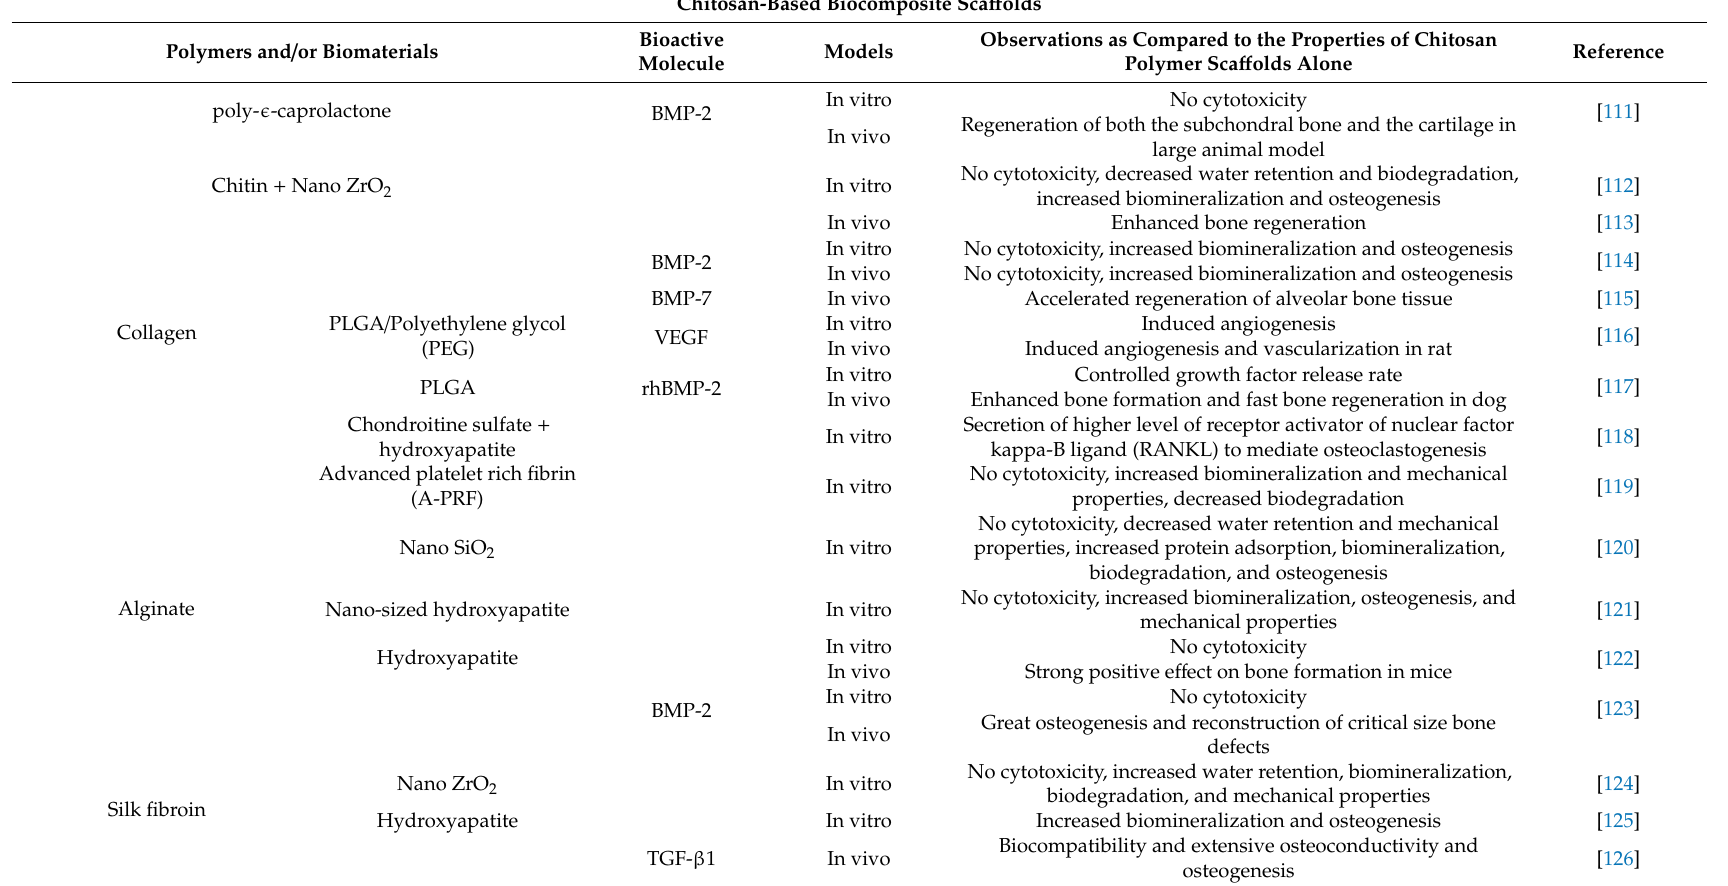
Polymers and / or Biomaterials